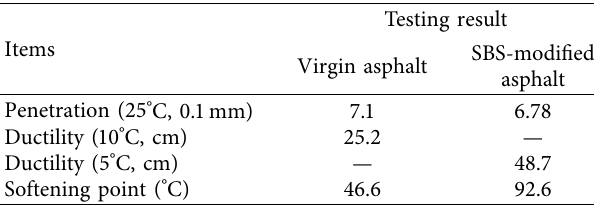
Table 2: Properties of virgin asphalt and SBS-modified asphalt.